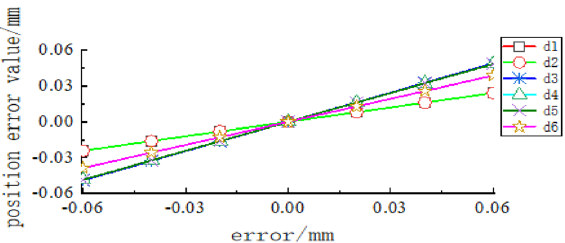
Figure 7. Sensitivity curve of linkage length error to terminal position error.